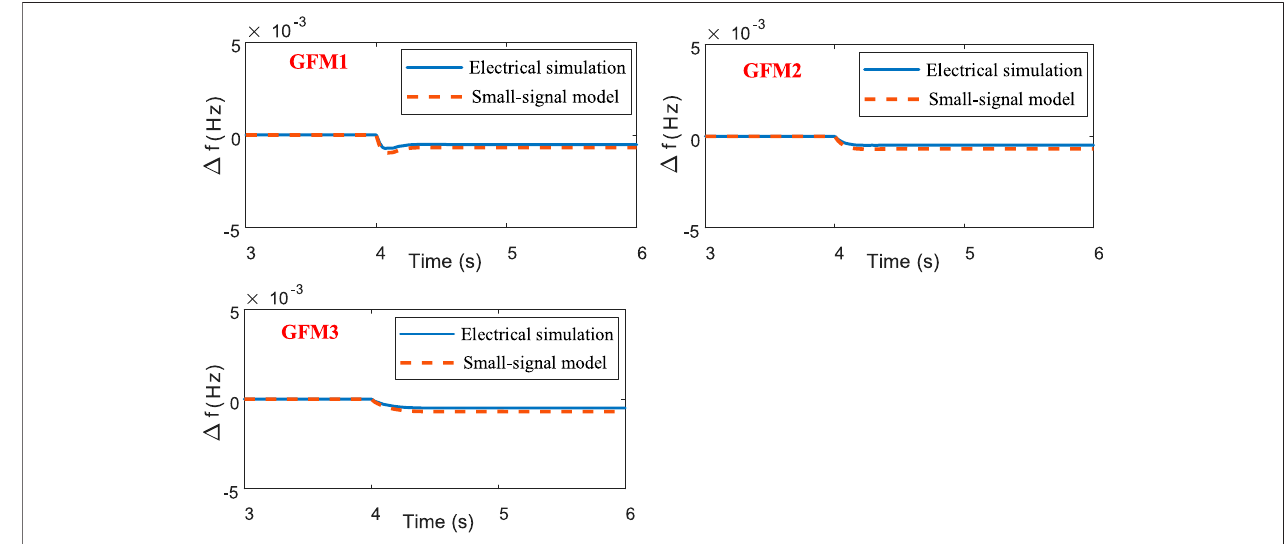
FIGURE 5 | Frequency response of the electrical simulation and the proposed small-signal model.